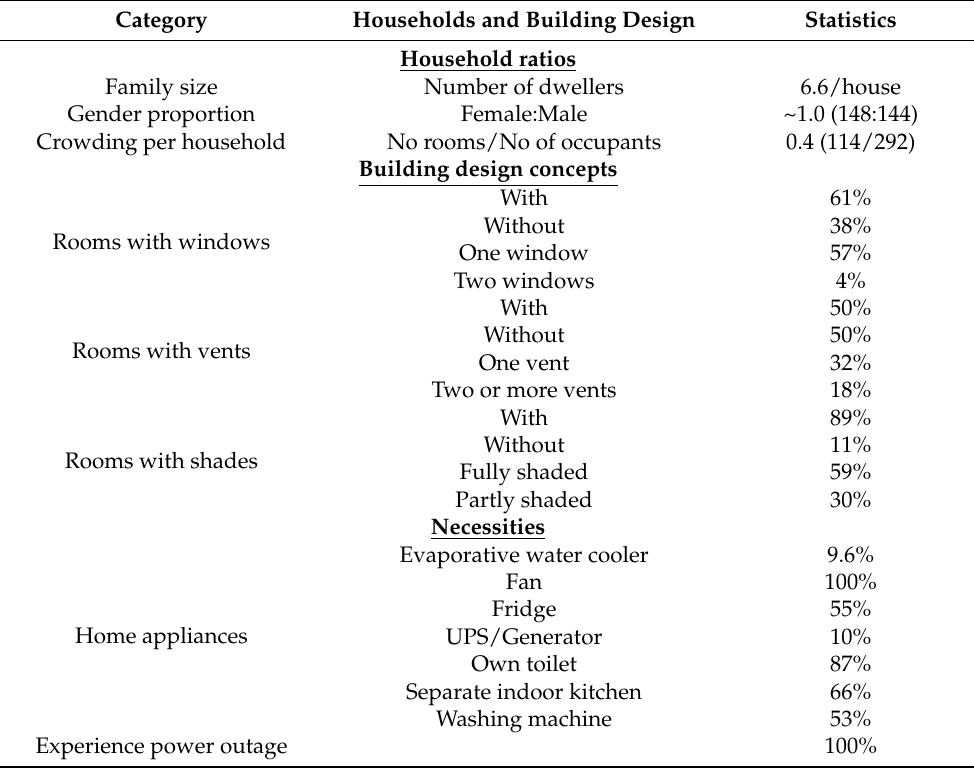
Table 1. Description of variables and summary statistics of socio-economic conditions and building design concepts of houses ( n = 52) considered in this